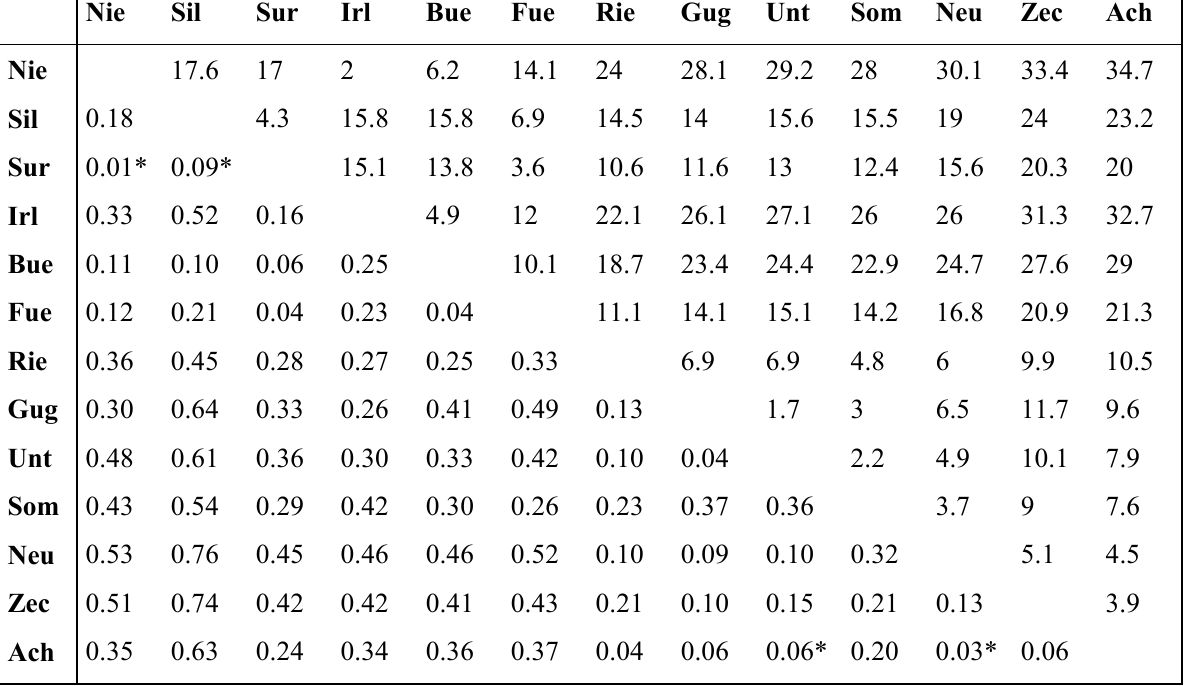
Table 3. The pairwise measure of genetic differentiation (F geographic distances (in km, upper triangle) between populations. These values were used in isolation by distance tests (see results). All F with asterisks